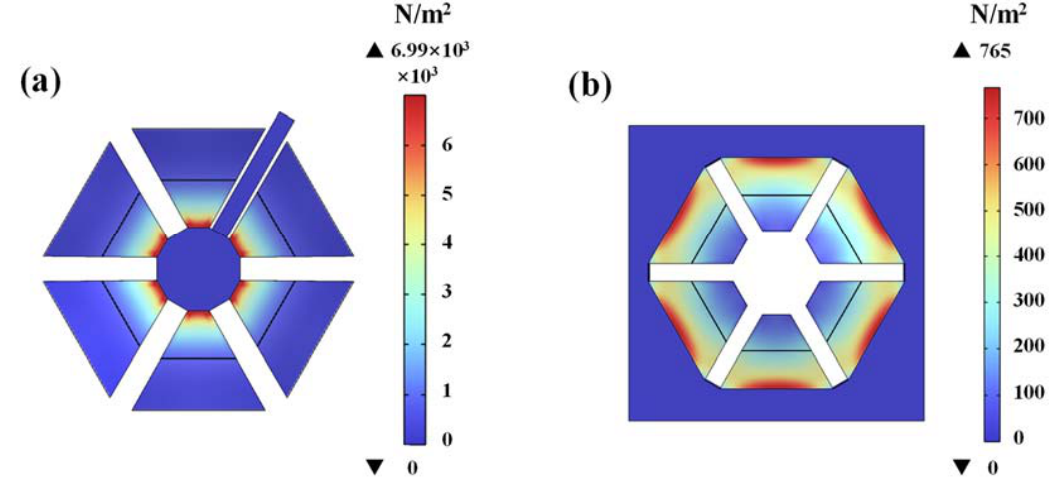
Figure 2. Stress distribution diagrams of ( a ) Type A and ( b ) Type B piezoelectric MEMS accelerometers at 400 Hz. Table 2. Material parameter values in this